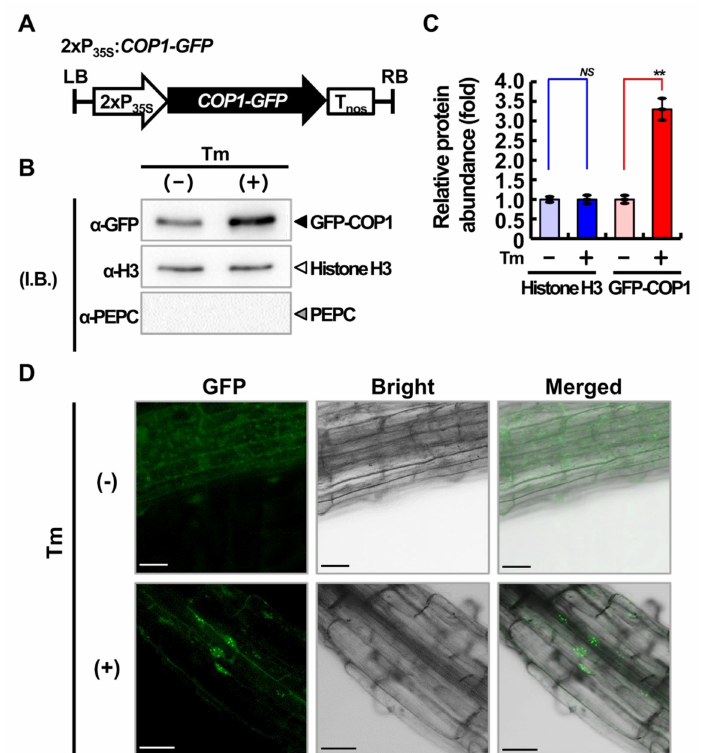
Figure 2. Nuclear enrichment of COP1 under ER stress. ( A ) Schematic representation of the construct used in the experiments. P 35S and T nos represent the cauliflower mosaic virus (CaMV) 35S promoter and nopaline synthase ( NOS ) terminator. ( B ) Comparison of the COP1-GFP fusion protein abundancy in the nucleus of Tm-treated (+) and untreated ( − ) transgenic plants harboring the construct depicted in ( A ). Total protein was extracted from transgenic plants, and the nuclear extract was fractionated. The COP1-GFP protein was detected by immunoblotting with anti-GFP antibody, and the nuclear specificity was determined using antibodies against marker proteins (anti-Histone H3, nucleus; and anti-PEPC, cytosol). ( C ) Quantification of the relative abundance (fold enrichment) of the nuclear- localized COP1-GFP protein. The abundance of histone H3 was determined as a control. Data represent mean ± SD of three independent biological replicates. Asterisks indicate statistically significant differences (Student’s t -test; ** p < 0.01; NS , not significant). ( D ) Translocation of COP1 protein in response to the Tm treatment. The root epidermis of transgenic plants overexpressing COP1-GFP were subjected to confocal microscopy before ( − Tm) or after (+Tm) treatment with 5 µ g/mL Tm for 6 h. Scale bars = 20 µ